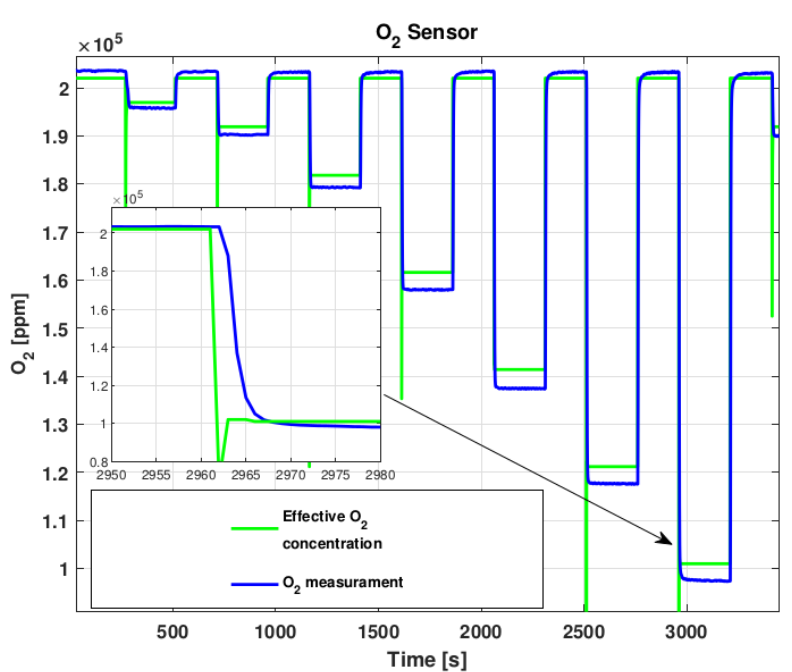
Figure 3. CO Sensor test.